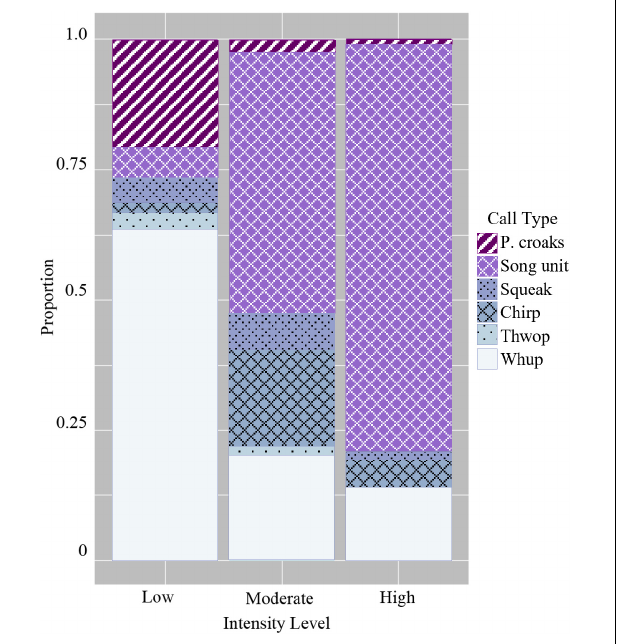
FIGURE 5 | Probability of detecting the six discrete call types in the three intensity